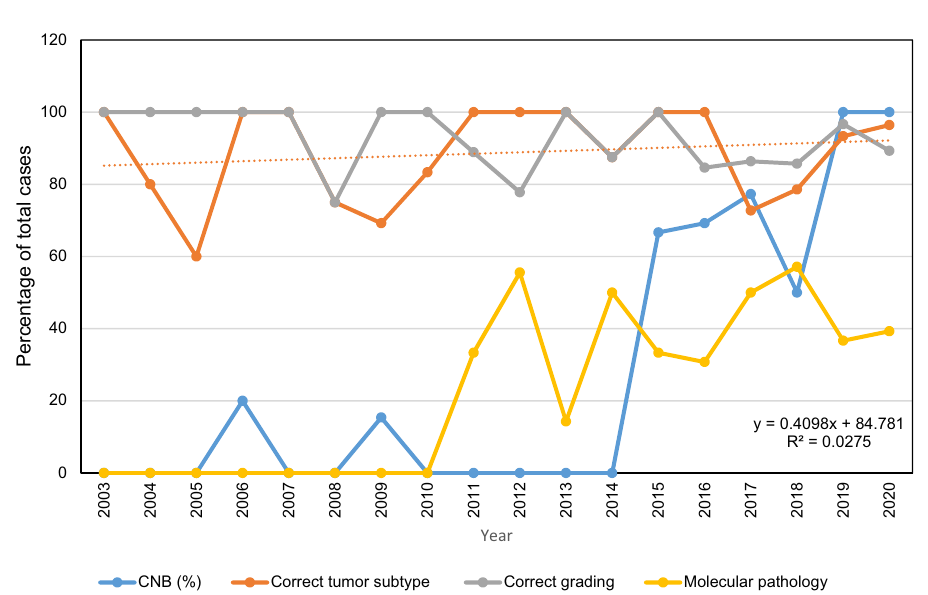
Figure 3. The level of diagnostic accuracy with regards to tumor type increased during the study period (R 2 = 0.02). Results for tumor accuracy have been fitted to create the regression line. An increase in molecular pathological testing is noted beginning in 2011, and an increase in the use of core needle biopsy (CNB) is noted from